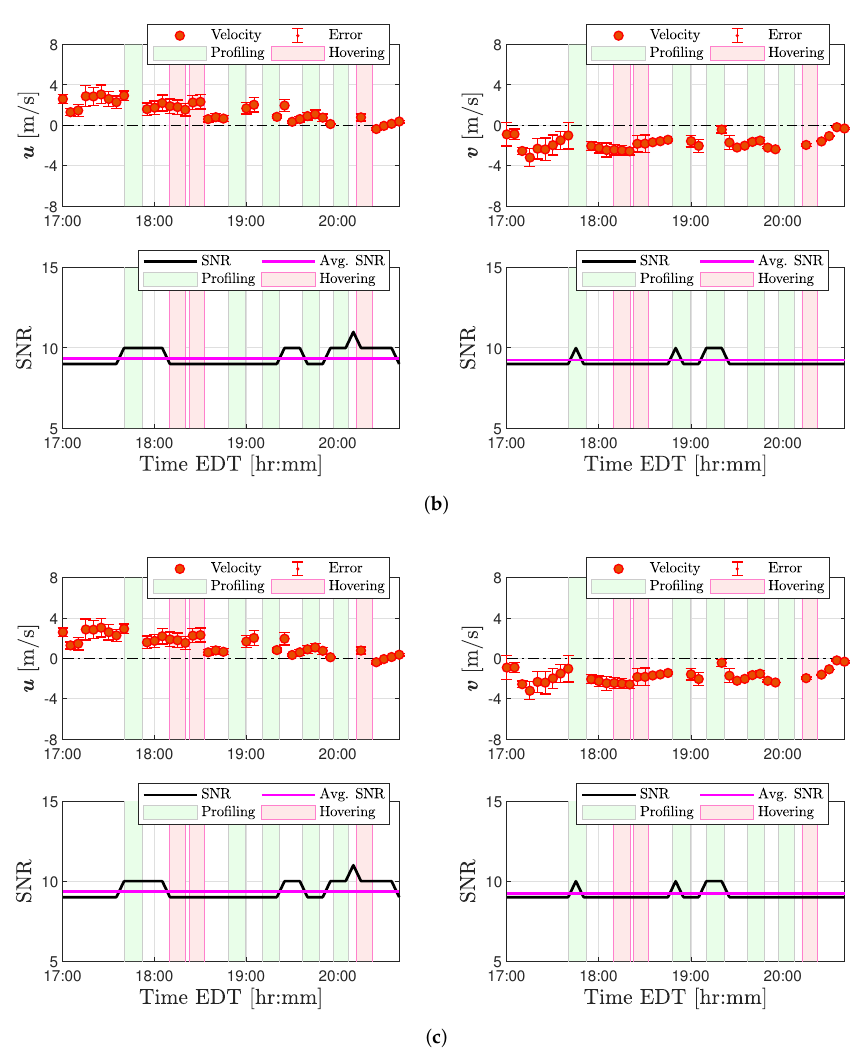
Figure A5. Signal-to-noise ratios for u and v wind velocity observations from the SR-SoDAR at ( a ) 110 m AGL, ( b ) 70 m AGL, and ( c ) 30 m